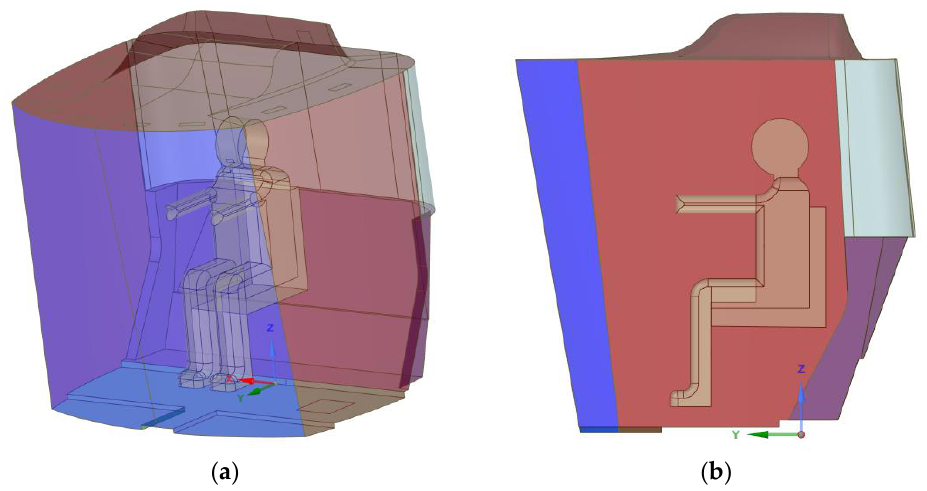
Figure 2. General view: ( a ) axonometry; ( b ) side view.